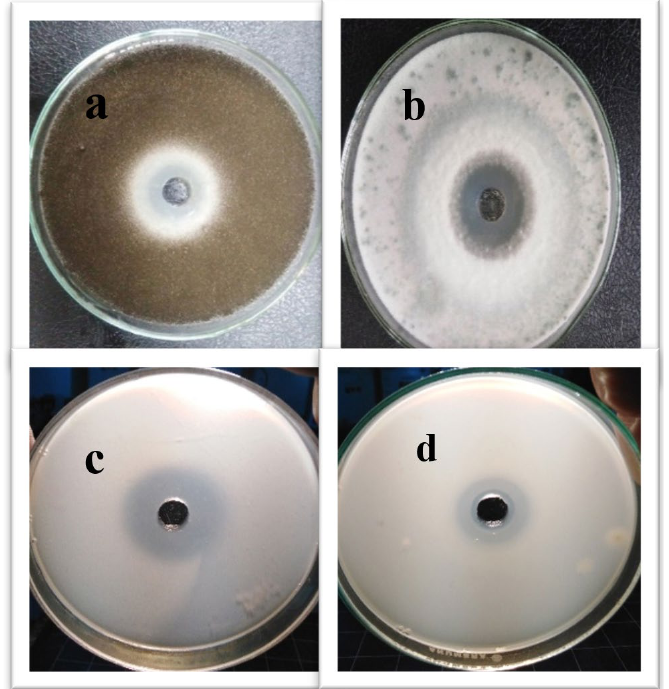
Fig. 12. Inhibition zones produced against (a) A. niger, (b) P. marneffie, (c) C.glabrata and (d) C. parapsilosis using as-prepared zinc oxide nanoparticles.